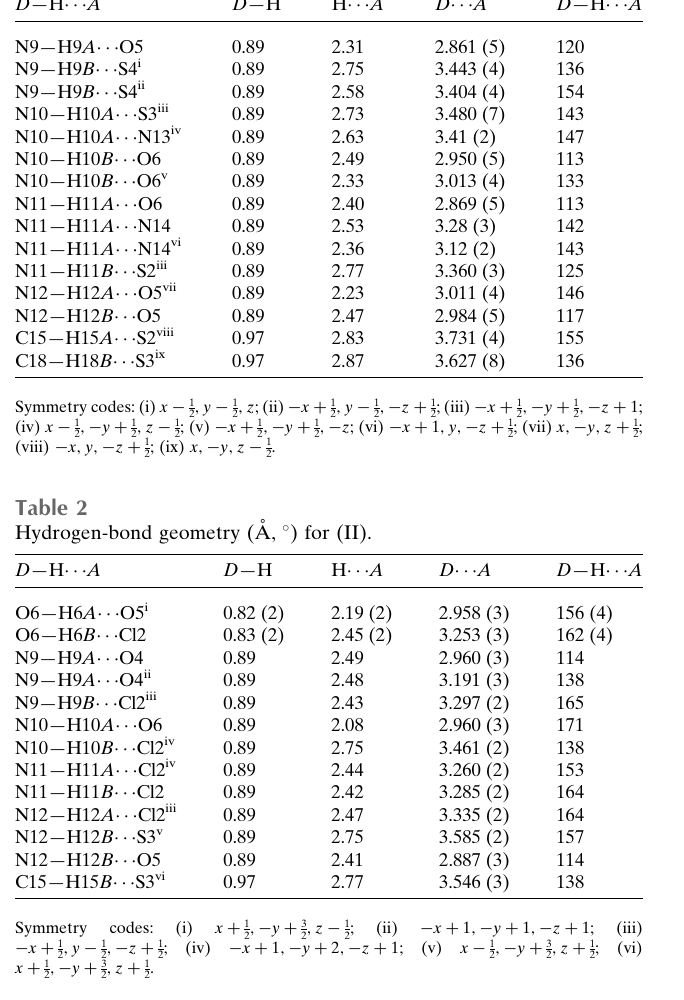
Table 1 Hydrogen-bond geometry (A˚ , (cid:5) ) for (I). D —H (cid:2)(cid:2)(cid:2) A